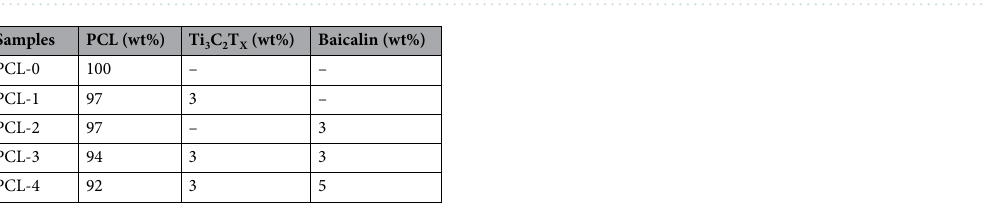
Table 1. Formulations of PCL based nanofibers.